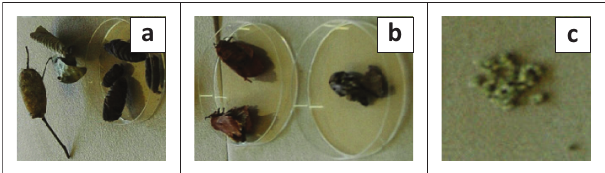
FIGURE 4: Occupied pupal cocoons (a) that were incubated leading to emergence of moths with red forewings (b) that subsequently laid white eggs with a black micropyle